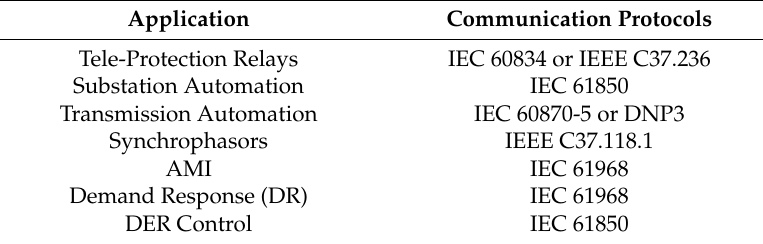
Table 1. The power system communication protocols